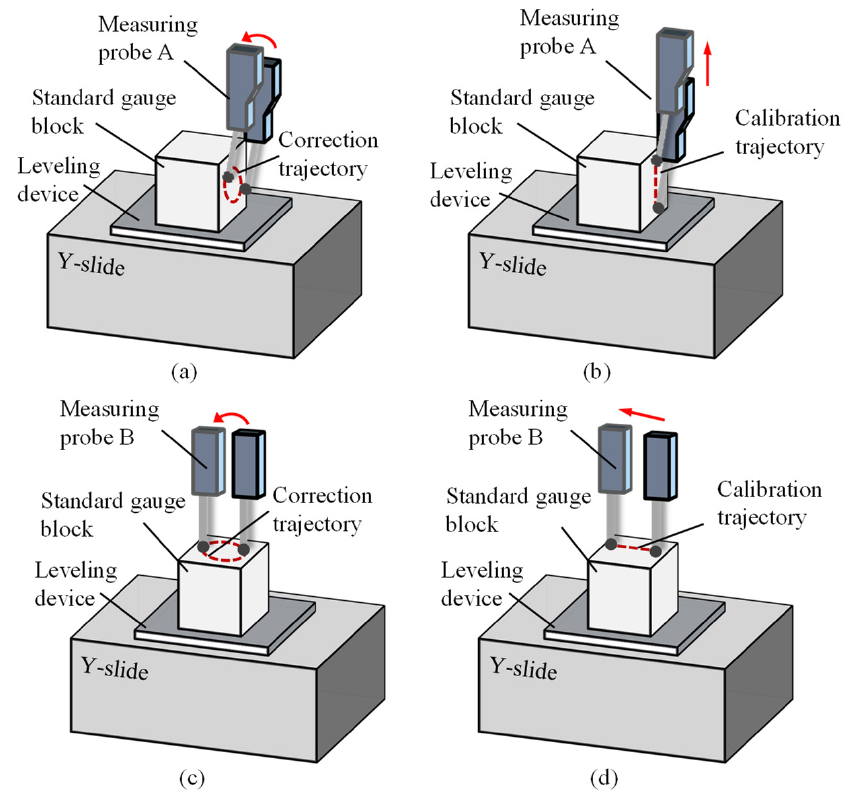
Figure 9. Schematic of slide motion error calibration. ( a ) Preparation for Z -slide motion error calibration; ( b ) Z -slide motion error calibration; ( c ) preparation for Y -slide motion error calibration; ( d ) Y -slide motion error calibration.